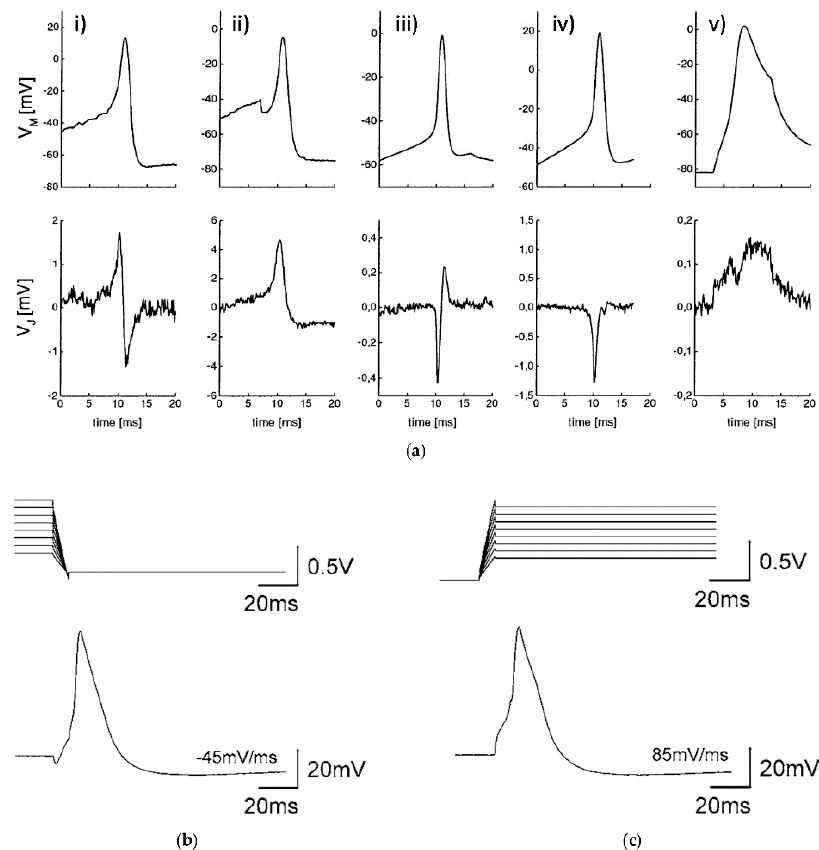
Figure 17. ( a ) Intracellular voltage V M elicited by injection of current measured with a micropipette (upper row) and extracellular voltage V J measured with a EOSFET (lower row): (i) capacitive response; (ii) ohmic response; (iii) anti-capacitive response; (iv) Early anti-capacitive response; (v) Early capacitive response with secondary positive response; ( b ) Capacitive stimulation under current-clamp by falling ramps; ( c ) Capacitive stimulation under current-clamp by rising ramps. ( a ) Reproduced from [146]. Copyright 1999, with permission of Springer; ( b , c ) Reprinted from [148]. Copyright 2007, with permission from Elsevier.